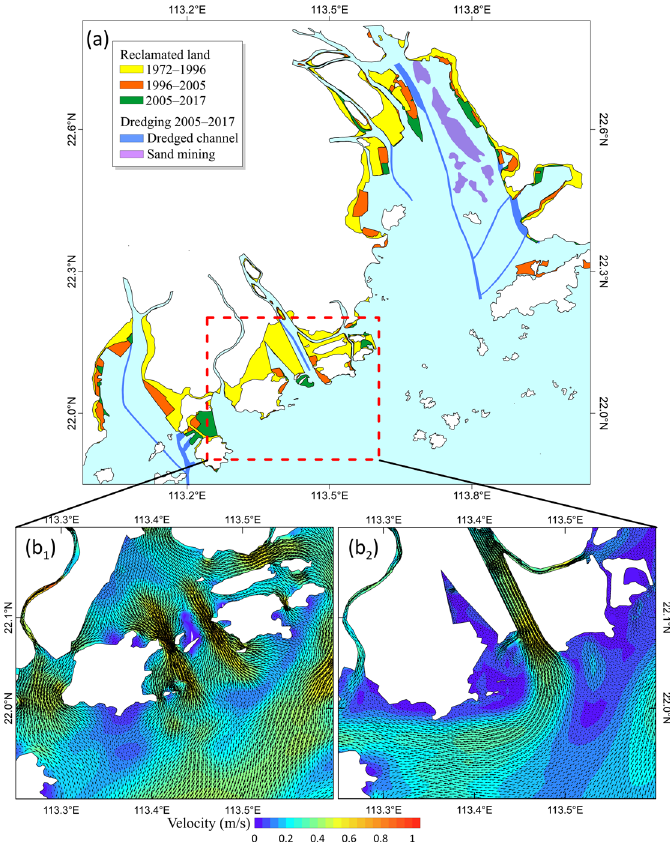
Figure 5. Schematic diagram of the locations of land reclamation, dredging channels, and sand mining in the Pearl River Estuary for 1972–2017 ( a ), and the ebb tide flow field at the Modaomen sub-Estuary in the summer of 1977 ( b 1 ) and 2003 ( b 2 ). Maps were created with Surfer, Version 13, https:// www. golde nsoft ware. com/ produ cts/